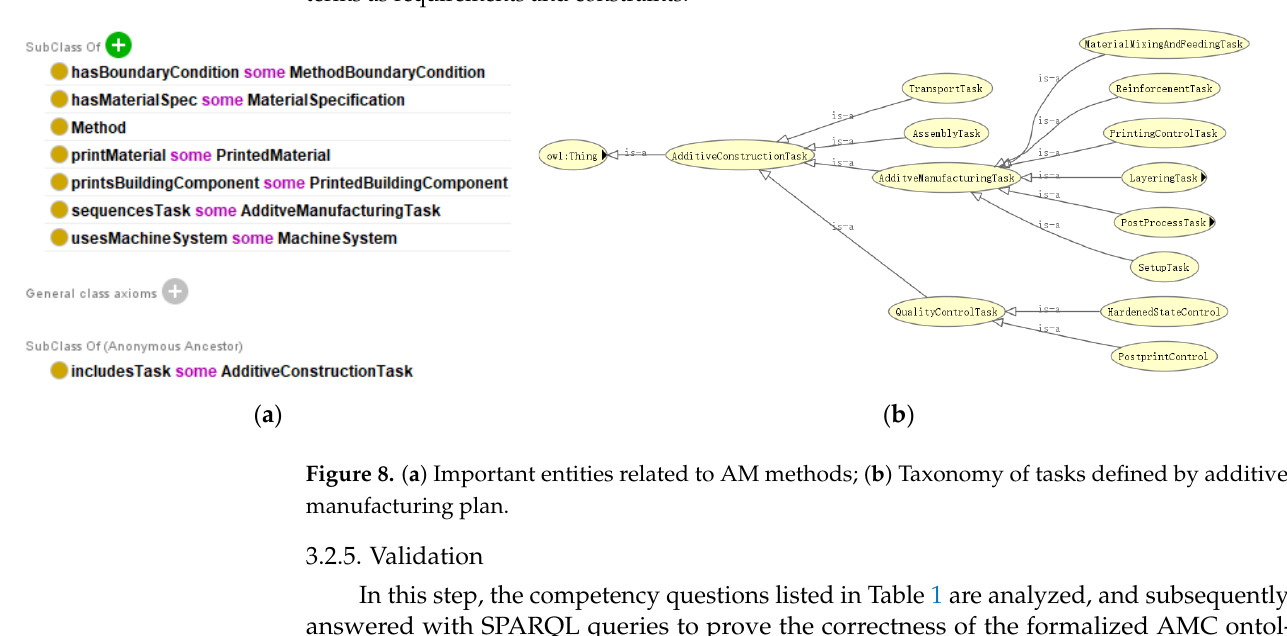
Figure 8. ( a ) Important entities related to AM methods; ( b ) Taxonomy of tasks defined by additive manufacturing plan.